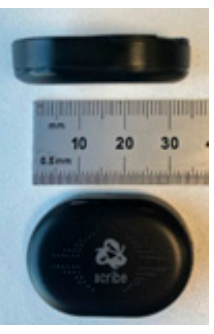
Figure 1. Sensors used.